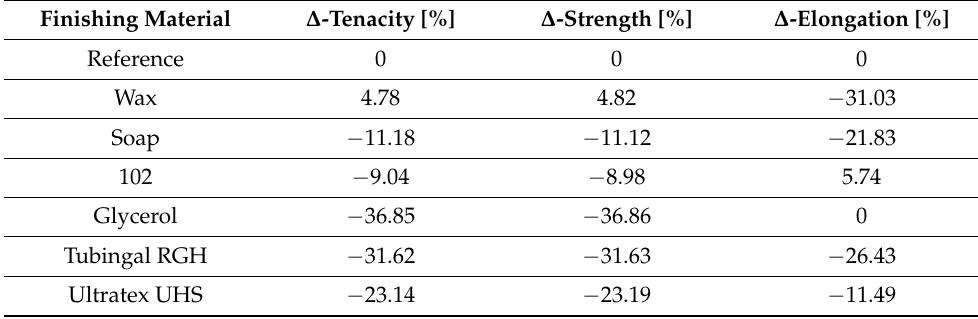
Table 1. The changes in tenacity, strength, and elongation for coated yarns. Finishing